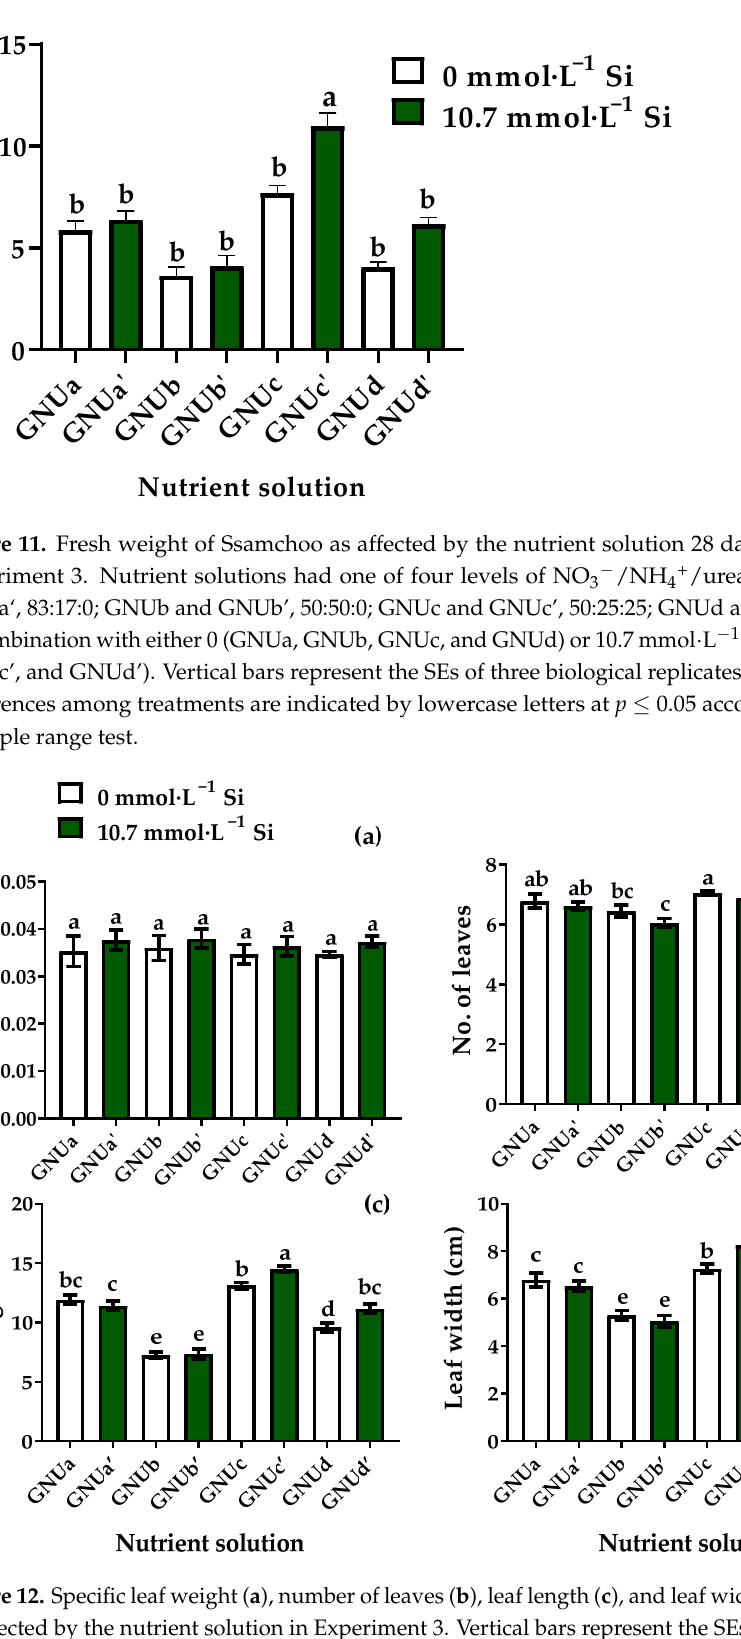
replicates ( n = 3). Significant differences among treatments are indicated by lowercase letters at